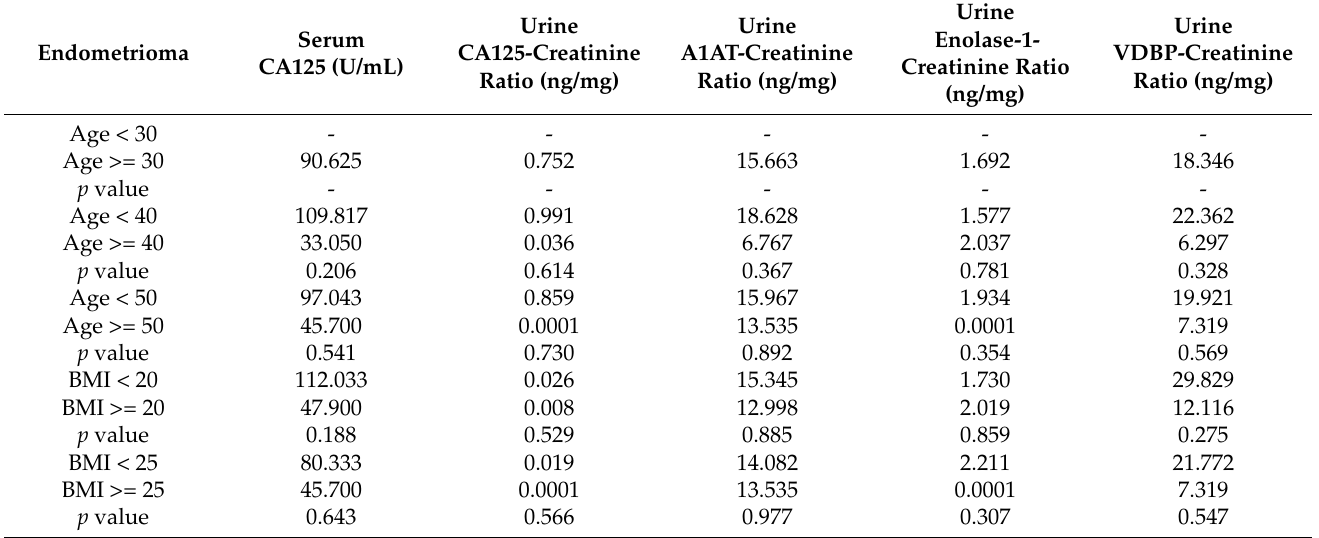
Table A3. The median values comparison of examined biomarkers in different subgroup analysis of parameters in patients with ovarian